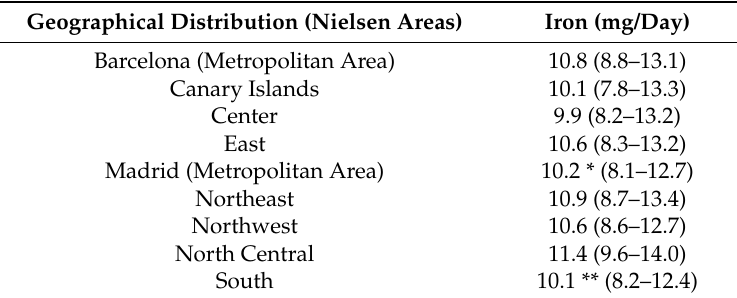
Table 6. Iron intake (mg/day) by geographical